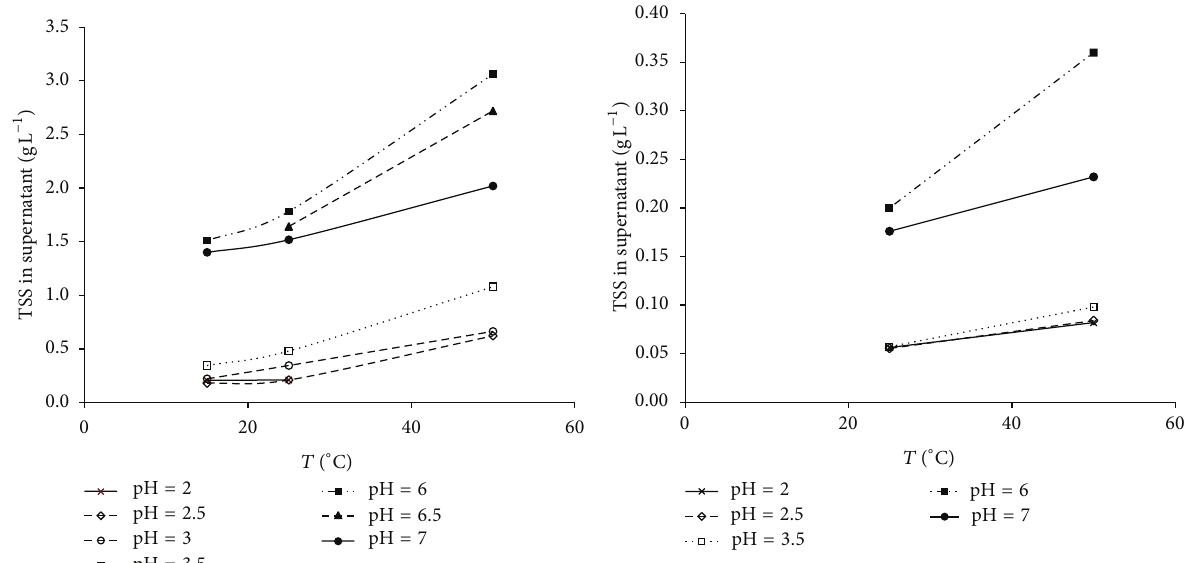
Figure 3: Lab-scale results of pH-T flocculation process on OMW (left caption) and MOMW (right capt.).